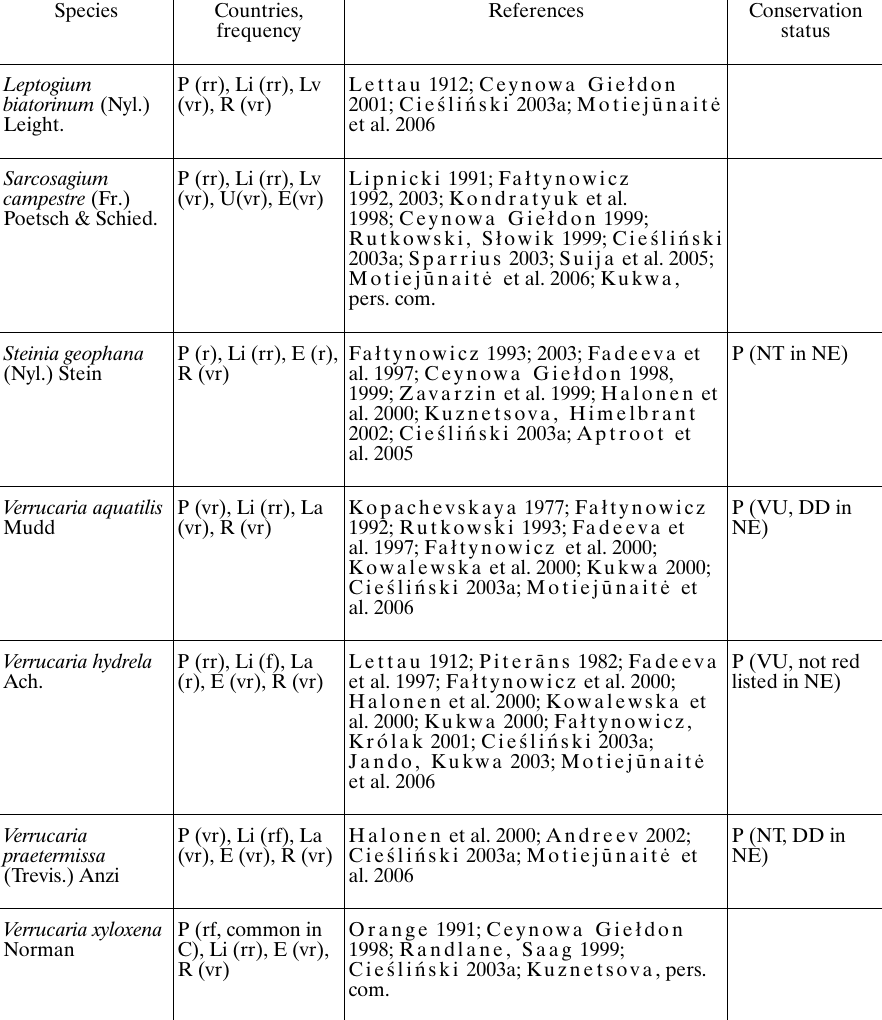
Distribution, frequency and conservation status of the selected lichen species in Eastern and East Central European